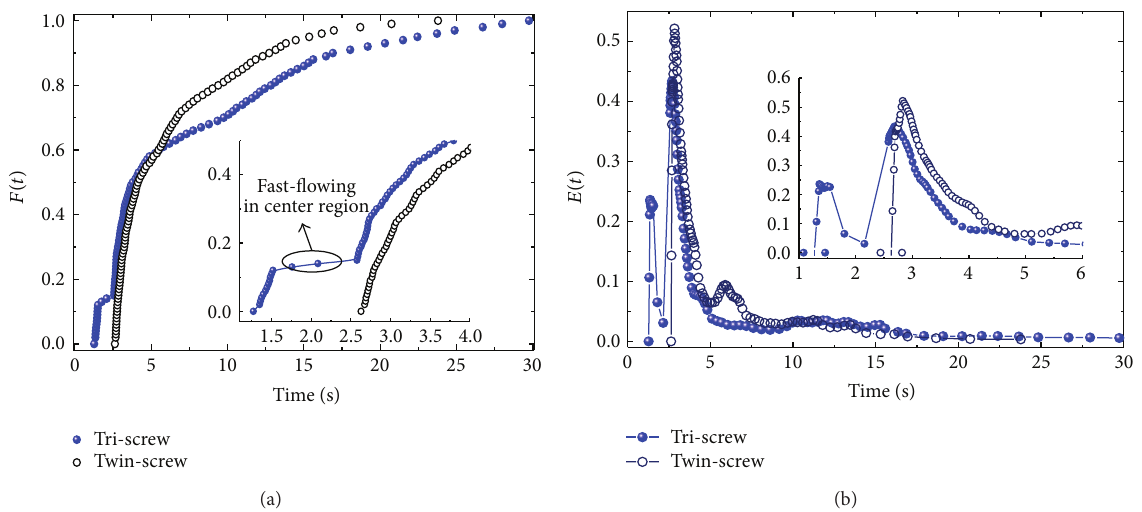
Figure 9: Cumulative RTD and RTD in the tri-screw and twin-screw extruders: (a) cumulative RTD; (b) RTD.